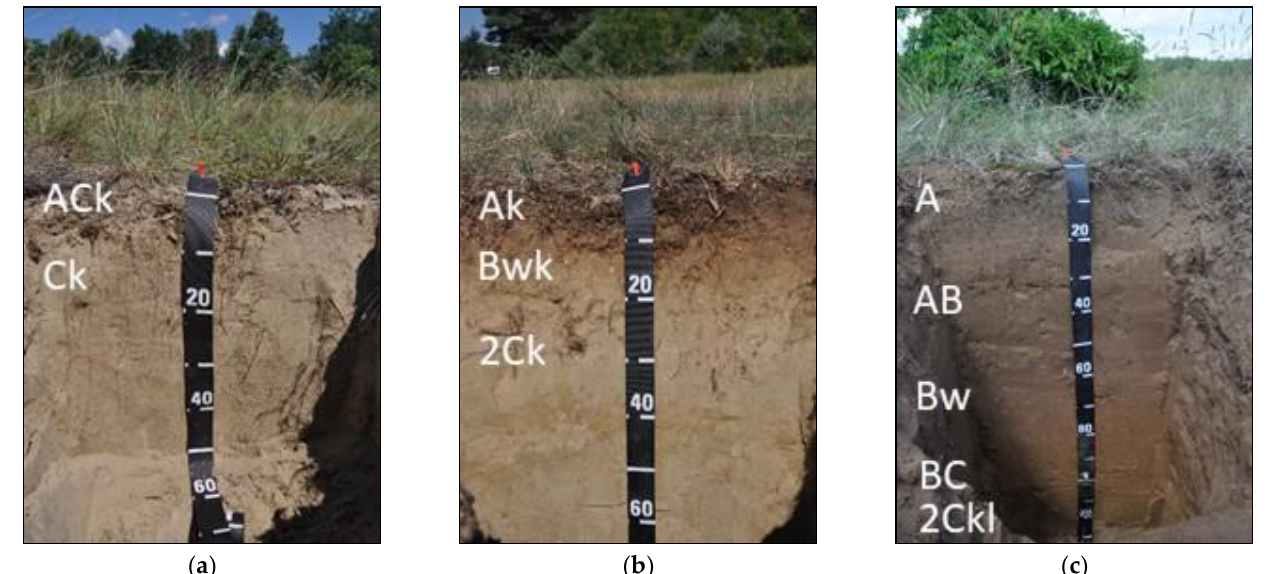
Figure 6. Soil profiles with genetic horizons [54] and classification according to the World Reference Base for Soil Resources [55]. ( a ) Calcaric Arenosol under F. vaginata; ( b ) Calcaric Arenosol under F. pseudovaginata and ( c ) Calcaric Brunic Arenosol under F. wagneri. Table 1. Basic soil chemical parameters of the genetic horizons of the soils profiles sampled under F. vaginata , F. pseudovaginata and F. wagneri